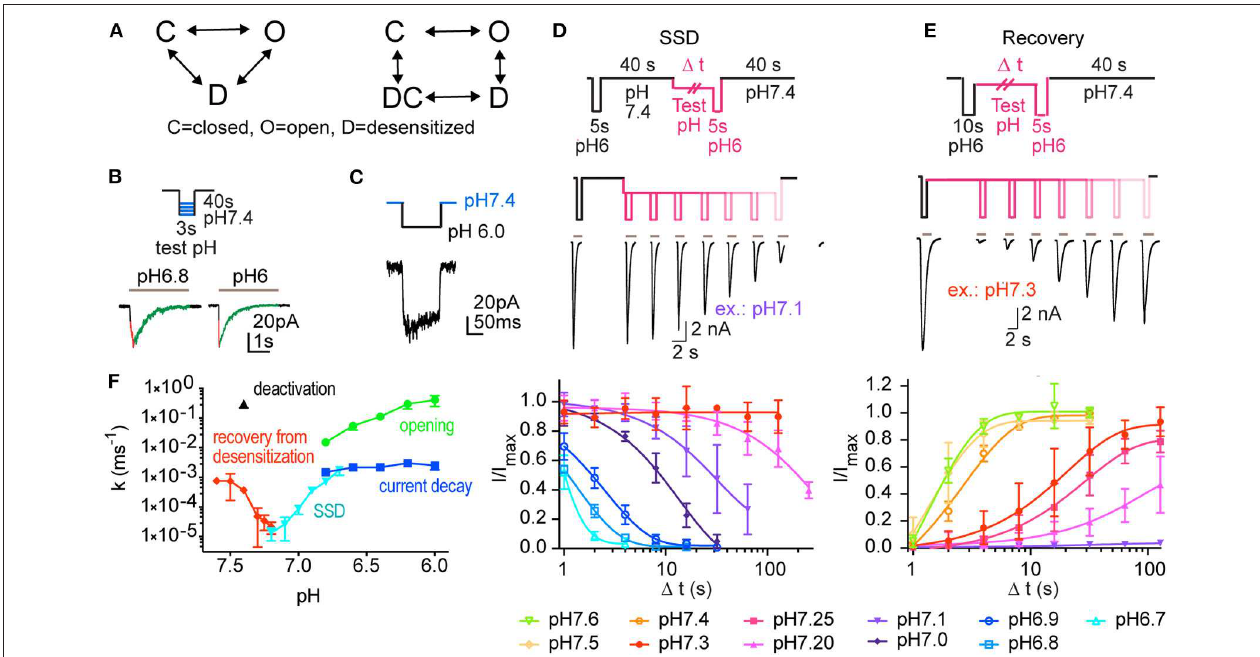
FIGURE 1 | Experiments analyzing the kinetics of ASIC1a. This figure reports the experiments done for creating a kinetic model of ASIC1a function. (A) Kinetic models describing ASIC function; left, model containing three functional states (C, closed; O, open; D, desensitized). Right, Hodgkin-Huxley (HH)-type model, in which activation transitions are horizontal, and (de)sensitization transitions are vertical, containing an open, a closed and two desensitized states, D and DC. (B–E) Currents were measured by outside-out (B,C) or whole-cell (D,E) voltage-clamp to − 60mV from CHO cells stably expressing ASIC1a. (B) ASICs were activated every 40s by switching from pH 7.4 to acidic test stimuli for 3s. The current appearance and decay were each fitted to a single exponential. A schematic protocol and representative current traces are shown. The two traces are from different patches. (C) To determine the kinetics of deactivation, the ASICs were activated every 40s by switching from pH 7.4 to the stimulation pH 6.0 for 120ms, and then exposed to pH 7.4. (D) The kinetics of entry into steady-state desensitization (SSD) were determined with the basic protocol shown on top. Channels were first exposed to pH 6.0 for 5s (control response), followed by a recovery at pH 7.4 for 40s. Next, the channels were exposed to a given conditioning pH for different time periods (one duration per sweep), followed by a second switch to pH 6.0 to assess the fraction of the channels having desensitized. Middle panel, pH protocol and representative current traces of an SSD experiment with conditioning pH 7.1. Bottom panel, kinetics of current decay as a function of exposure duration, shown for different conditioning test pH conditions ( n = 2–11). (E) Recovery from desensitization; protocol shown in top panel. Channels were first exposed to pH 6.0 for 10s, leading to opening and subsequent desensitization. Next, they were exposed to a given conditioning pH for increasing time periods, followed each time by a second exposure to pH 6.0. Middle panel, pH protocol and current traces of a representative experiment with conditioning pH 7.3. Bottom panel, kinetics of current recovery from desensitization, as a function of exposure duration, shown for different recovery test pH ( n = 3–13). (F) Rate constants derived from the different protocols used in B-E, shown as a function of pH. n = 3–36 (opening), 11 (deactivation), 2–19 (current decay), 4–8 (SSD kinetics), and 3–11 (recovery from desensitization).